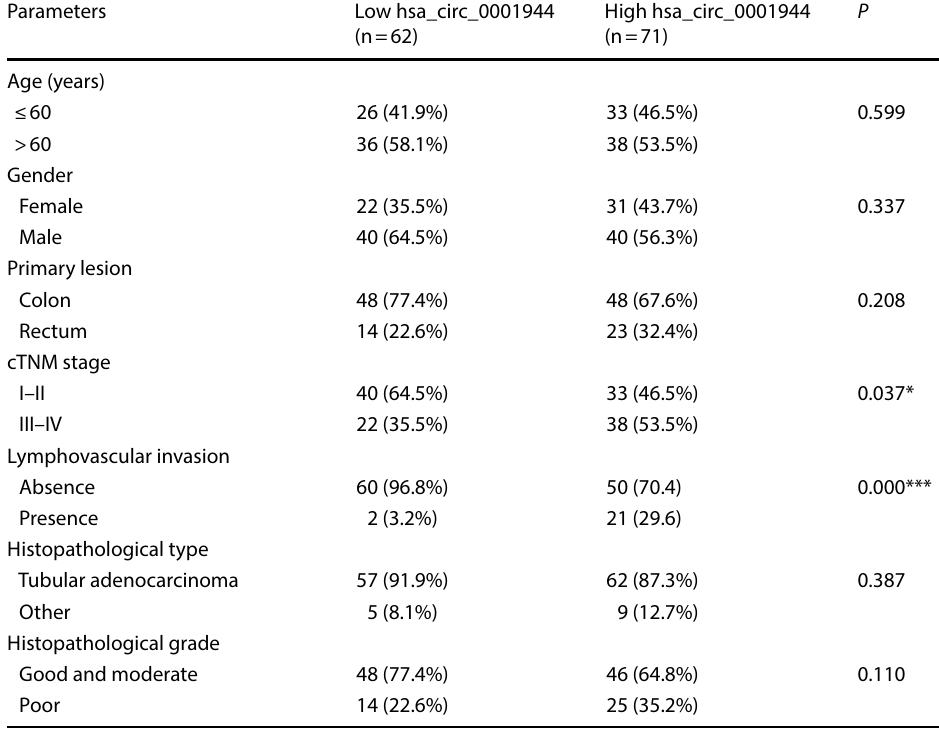
Table 1 Correlations between hsa_circ_0001944 expression and clinico-pathological